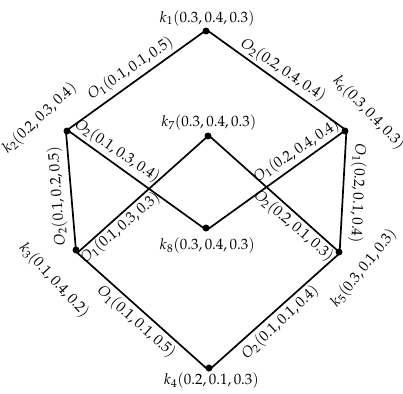
Figure 4. An IN spanning-subgraph structure.